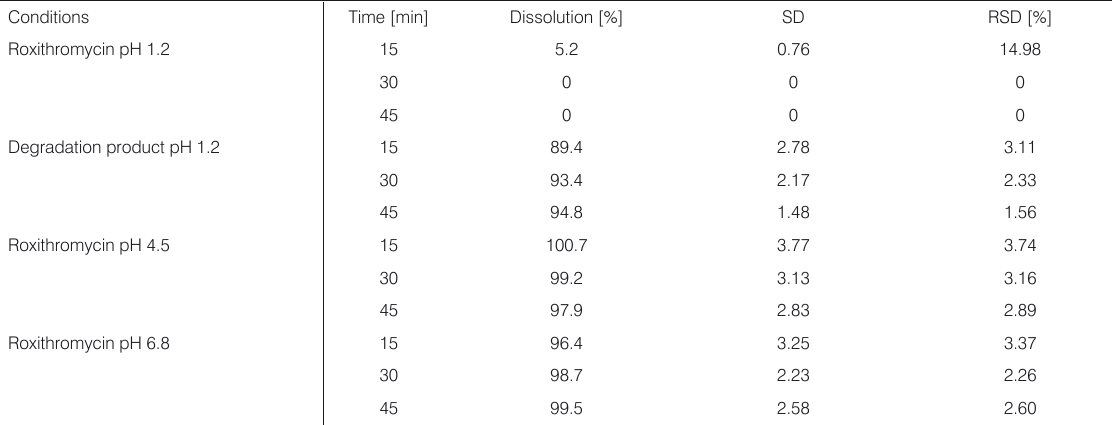
roxithromycin degradation product pH 1.2 Table 3. Dissolution of roxithromycin and its degradation product from suspension at pH 1.2, 4.5, and 6.8.